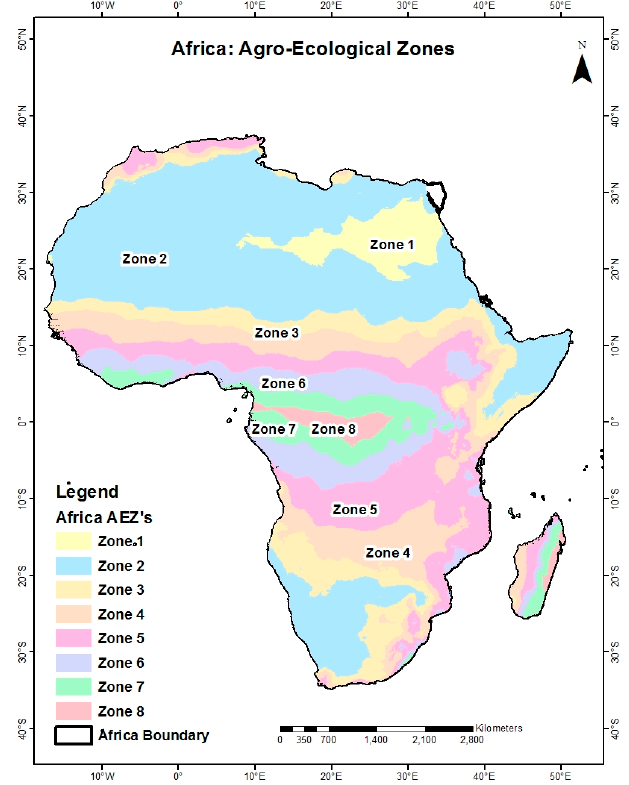
Figure 7. Agro-Ecological Zones (AEZ’s) of Africa.